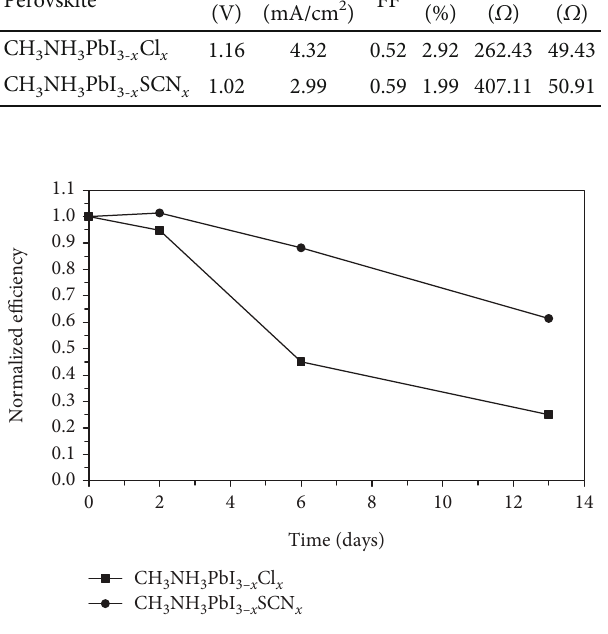
Figure 5: The stability test of perovskite solar cell